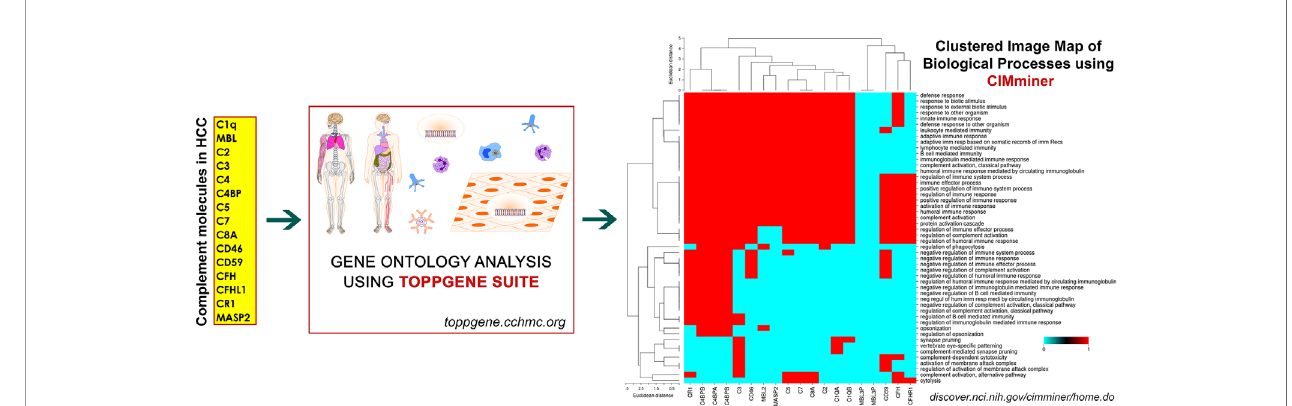
FIGURE 4 | Bioinformatics analysis identi fi es dominant signatures of immune – mediated biological processes. Supervised gene ontology (GO) annotation analysis of complement components in hepatocellular carcinoma (HCC) was performed via ToppGene Suite portal (http://toppgene.cchmc.org) for in-silico enrichment of biological processes with a threshold False Discovery Rate (FDR) corrected P value of <0.05. ToppGene Suite is a freely available online tool used for functional enrichment, prioritization of candidate genes using transcriptome, ontology, phenotype, proteome, and functional annotations. GO: biological processes identi fi ed by ToppGene were further subjected to functional enrichment using CIMminer (https://discover.nci.nih.gov/cimminer/home.do). Red areas depicted in the heatmap show closely related biological processes linked to immunity that are shared by a major group of complement molecules shown on the horizontal